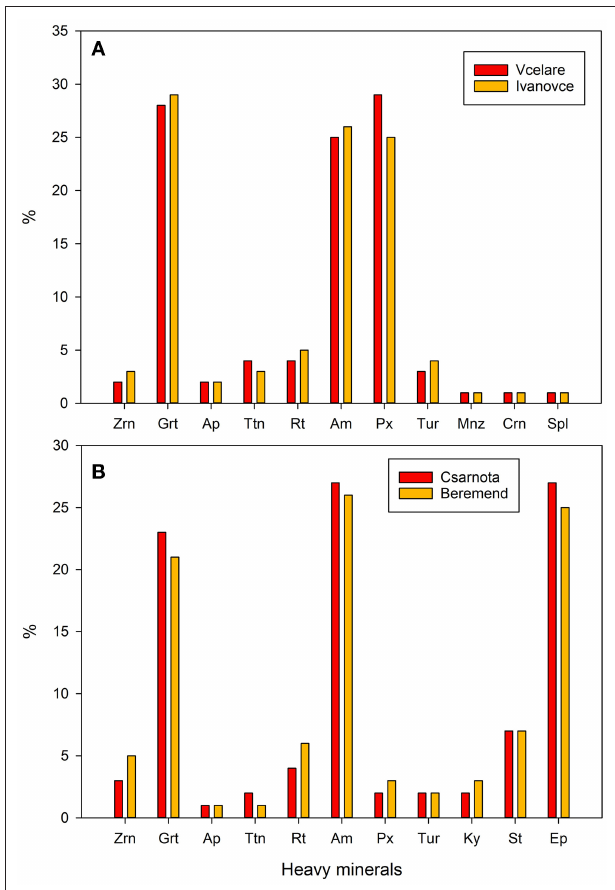
FIGURE 4 | Heavy mineral assemblages from Slovakia (A) and Hungary (B) . Zrn, zircon; Grt, garnet; Ap, apatite; Ttn, titanite; Rt, rutile; Am, amphibole;